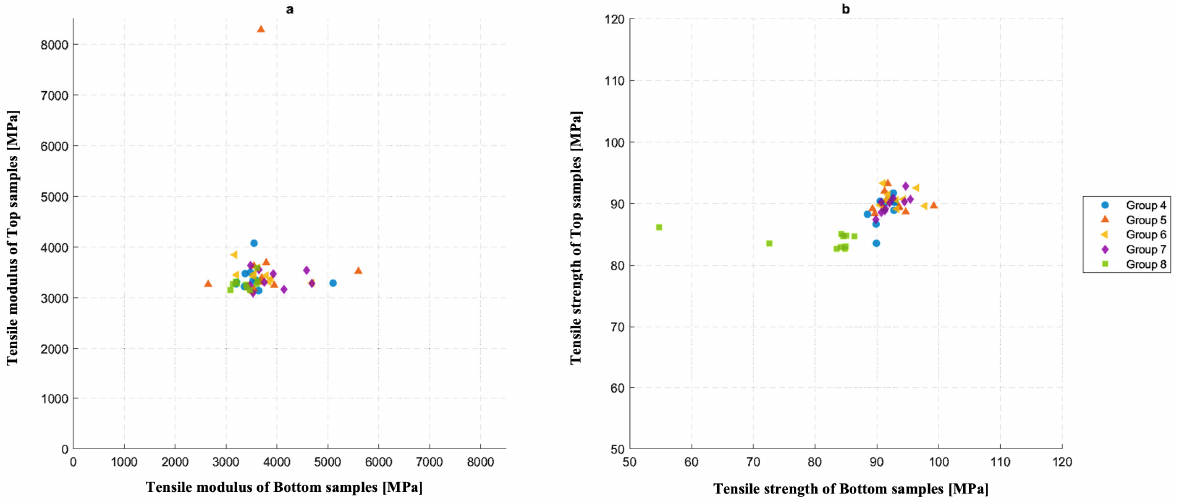
Figure 8. Distribution of ( a ) tensile modulus and ( b ) tensile strength between the bottom and top samples.